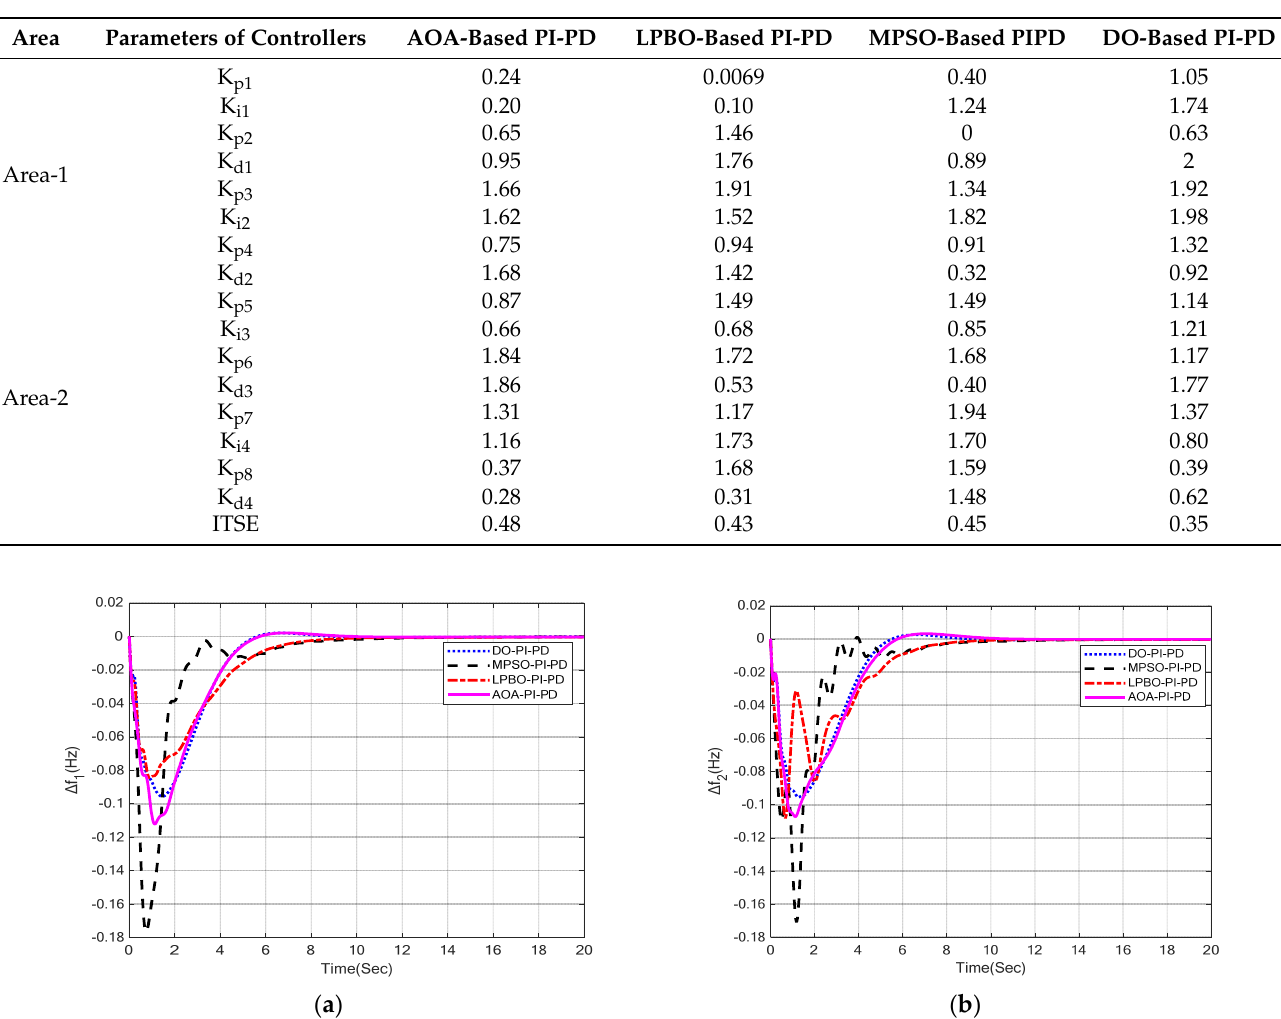
Table 8. Optimum controller parameters in a two-area multi-source realistic IPS with nonlinearities.